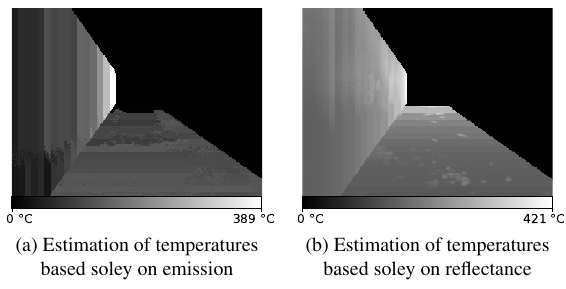
Figure 8. Separation of estimated emission and estimated reflectance.